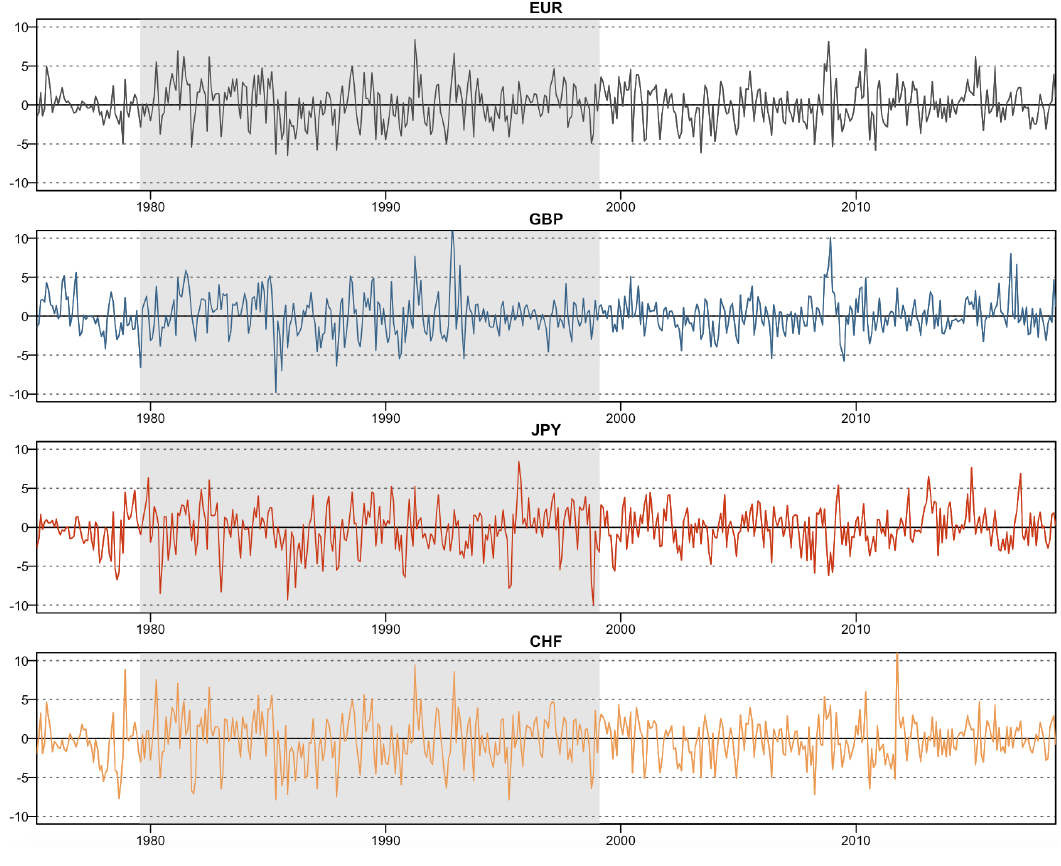
Figure 4. Exchange rate